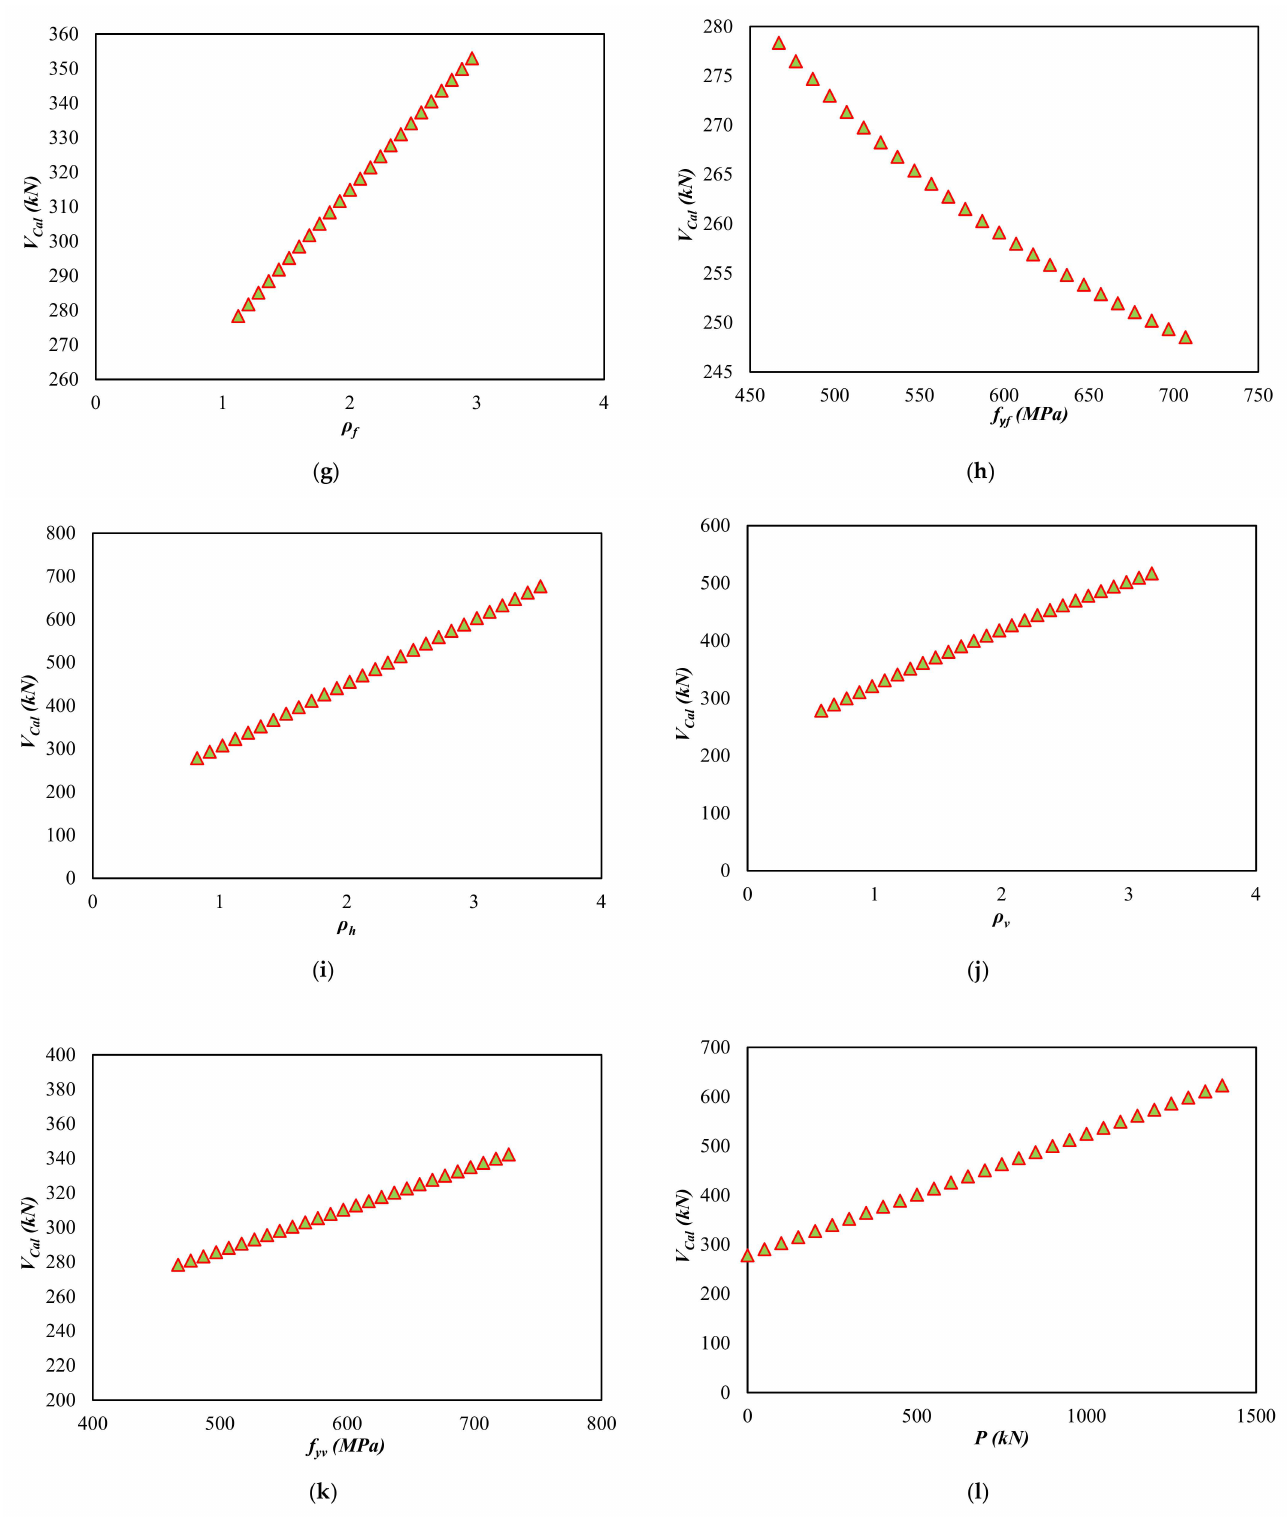
Figure 6. Sensitivity of each influencing parameter on the shear strength of RC flanged and barbell squat wall. ( a ) Height of wall ( h w ), ( b ) Web length ( lw ), ( c ) Web thickness ( t w ), ( d ) Flange thickness ( t f ), ( e ) Flange elements length ( l f ), ( f ) Compressive strength of concrete ( f c ), ( g ) Reinforcement ratios of flenge ( ρ f ), ( h ) Yield strength of flenged reinforcement ( f yf ), ( i ) Reinforcement ratio of wall in the horizontal direction ( ρ h ), ( j ) Reinforcement ratios of wall in vertical direction ( ρ v ), ( k ) Yield strength of vertical bars ( f yv ), ( l ) Axial load in wall